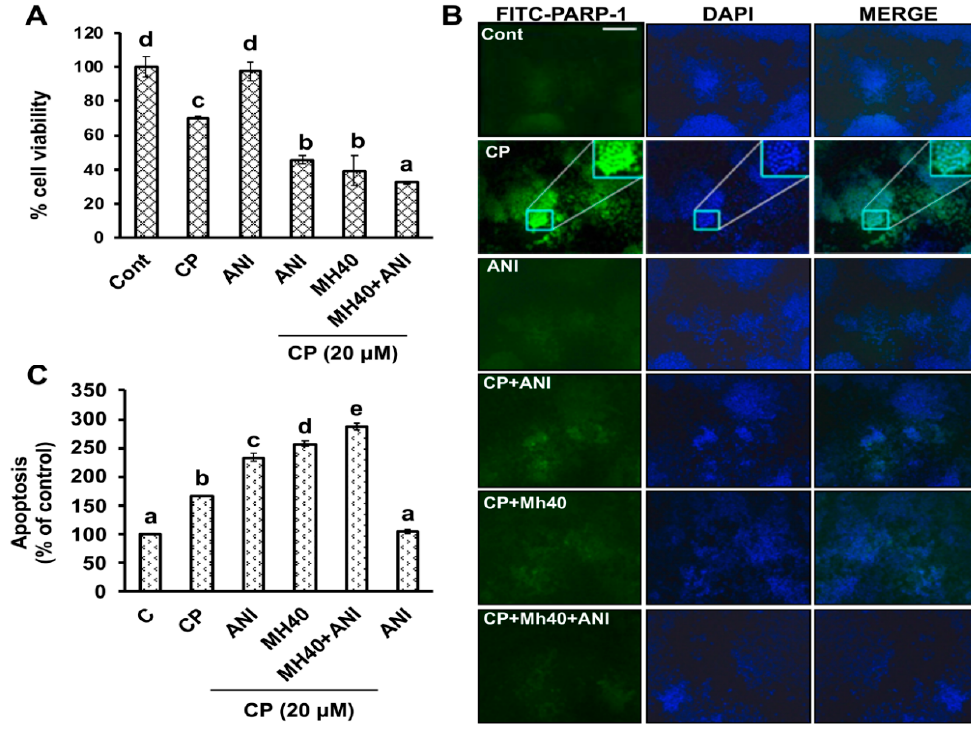
Figure 7. Inhibition of PARP-1 expression increases sensitivity of HepG2 cells to CP. ( A ) cell viability was evaluated by MTT assay after treatment with indicated concentrations of CP for 24 h in the presence or absence of ANI (10 μ M) and MH (40 μ M). ( B ) Immunocytochemistry of HepG2 cells for PARP-1 expression after corresponding drug treatment performed using fluorescein isothiocyanate (FITC) tagged anti-PARP-1 antibody and observed under fluorescence microscope (scale bar 0.1 mm); nuclear stain with DAPI (blue). ( C ) Percent apoptosis in HepG2 cells after corresponding drug treatment measured by ApoStrand™ enzyme-linked immunosorbent assay (ELISA) apoptosis detection kit. The data are presented as the means standard deviation ( n = 3). Values with different letters (a–e) differ significantly from each other ( p < 0.05).